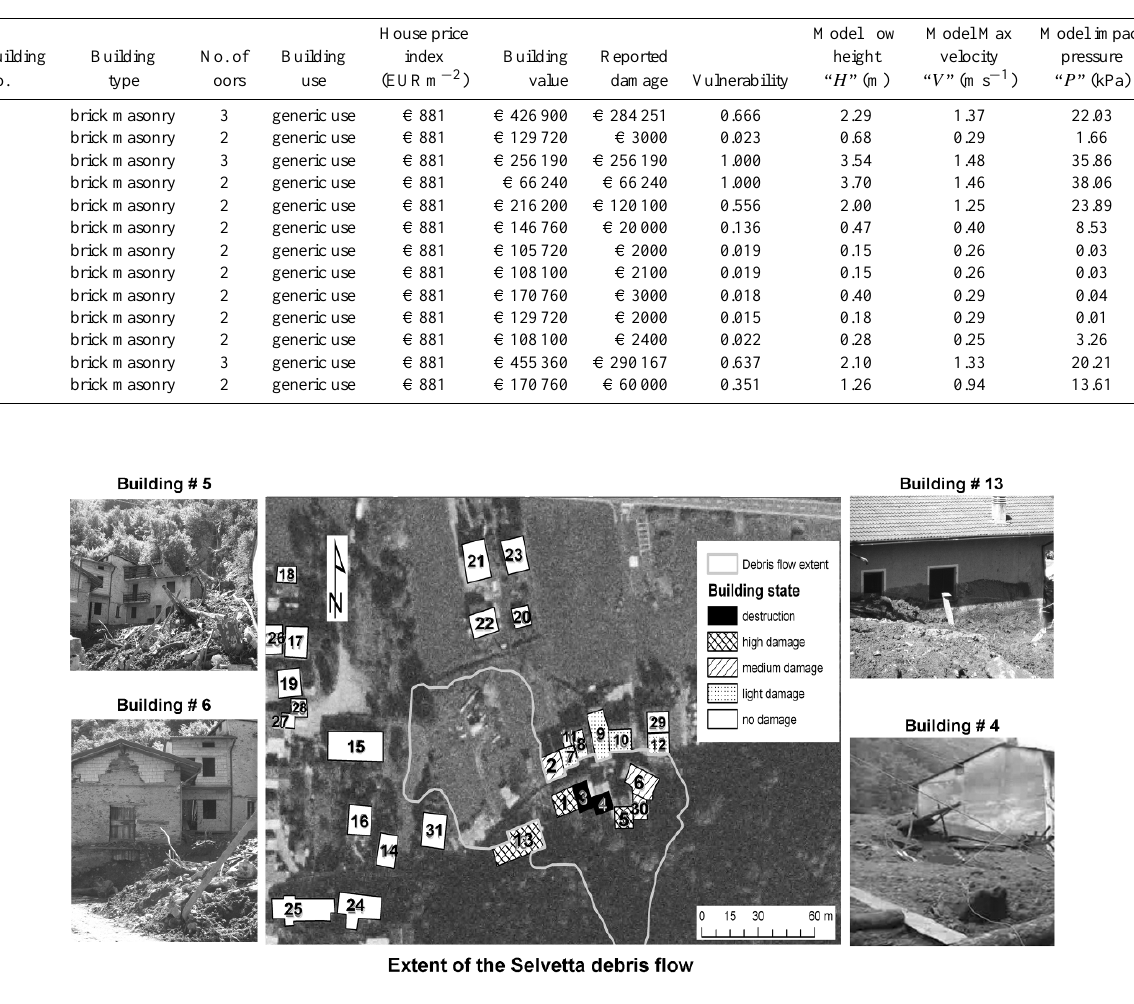
Fig. 7. Extent of the Selvetta debris flow damage to buildings is shown. Destruction: V =1; heavy damage: V =0.5–1; medium dam- age: V =0.1–0.5; light damage: V